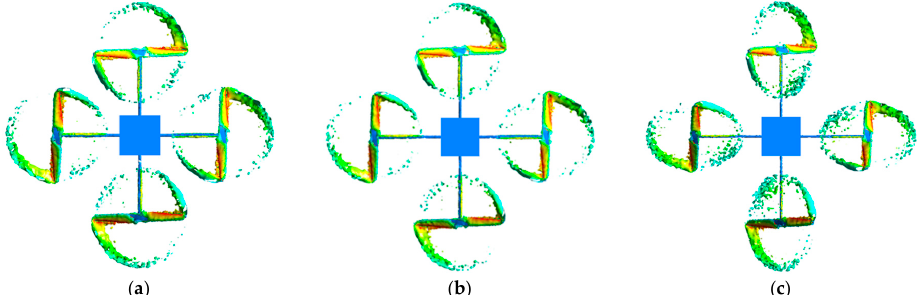
Figure 12. Vorticity distribution defined by the Q criterion: ( a ) 73,040 s − 2 at 30-1.1; ( b ) 73,037 s − 2 at 30-1.2; ( c ) 132,047 s − 2 at 50-1.2.